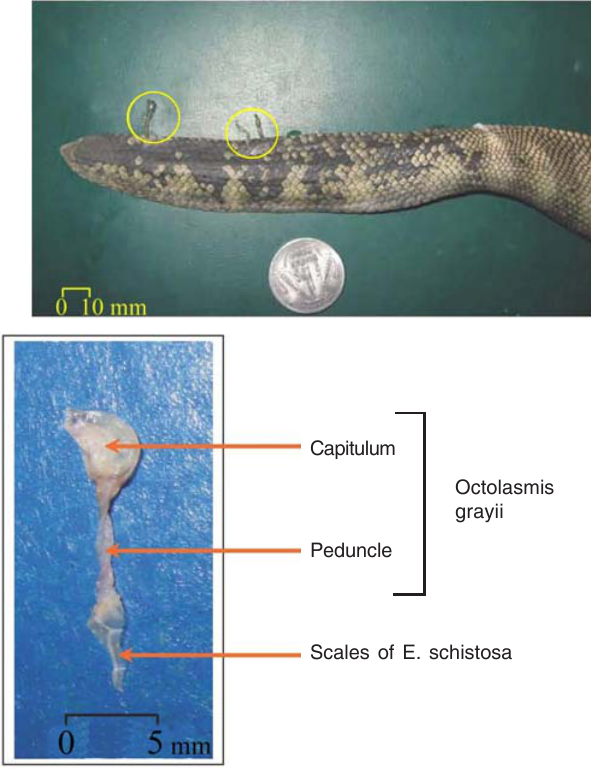
Image 4. Symbiotic association between sea snake and